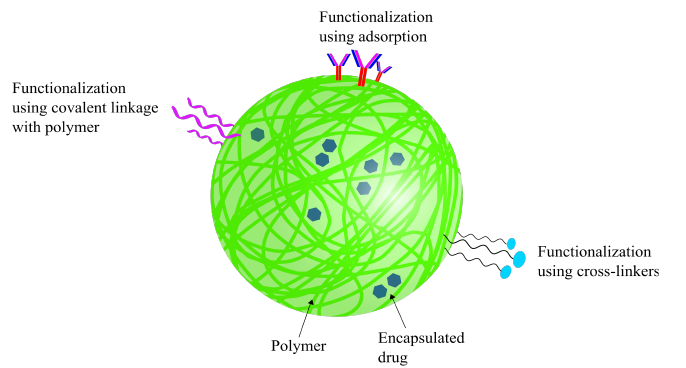
Figure 12. A schematic representation of an SNP which can be functionalized using covalent linkage through crosslinkers as well as through